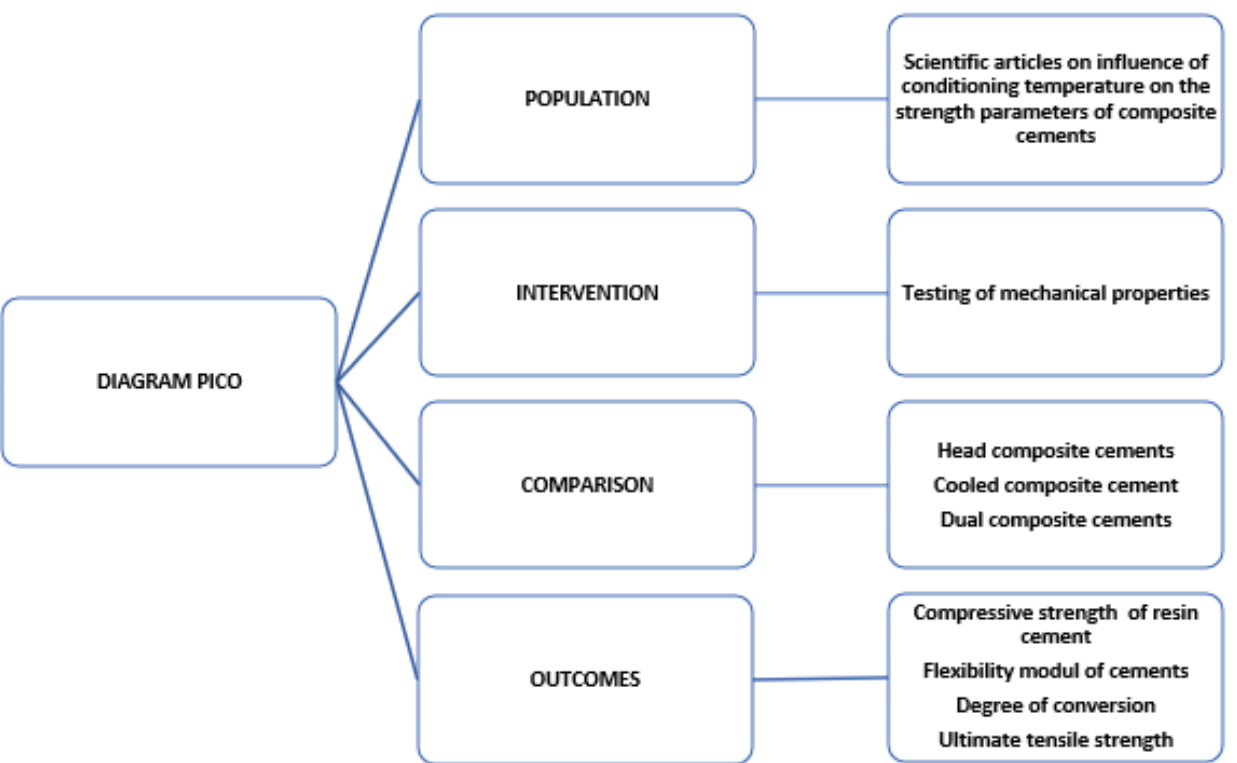
Figure 1. The PICO diagram implemented in this review